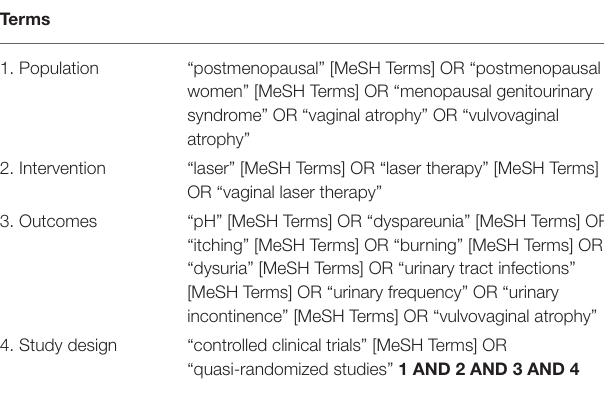
TABLE 1 | Search strategy applied to